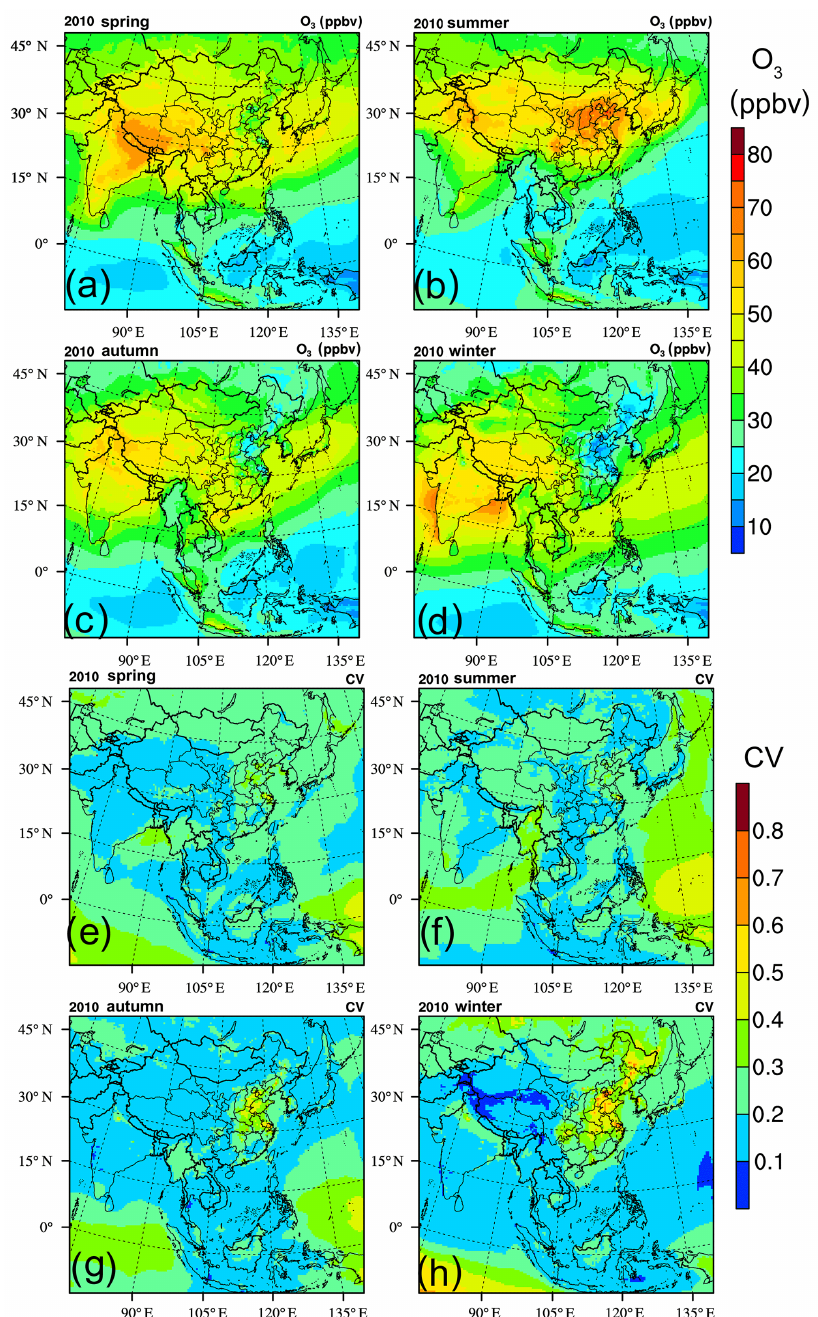
Figure 6. Ensemble mean seasonal surface O 3 concentrations and CV values for different seasons. CV is defined as the standard deviation of the modeled fields divided by the average for different